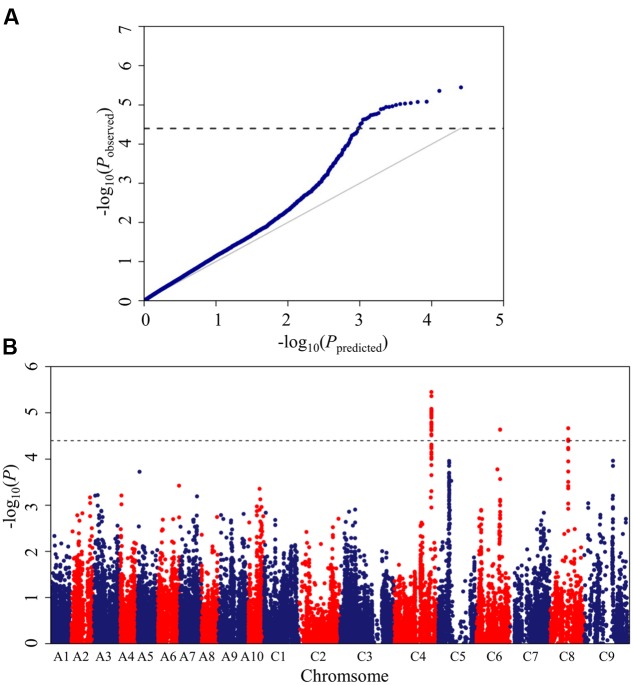
Quantile-quantile and Manhattan plots for the GWAS (genome-wide association study) of stem resistance to Sclerotinia sclerotiorum in B. napus.
(A) Quantile-quantile plots for stem resistance. (B) Manhattan plots for stem resistance. The dashed horizontal line depicts the uniform significance threshold (–log101/25,573 = 4.4).